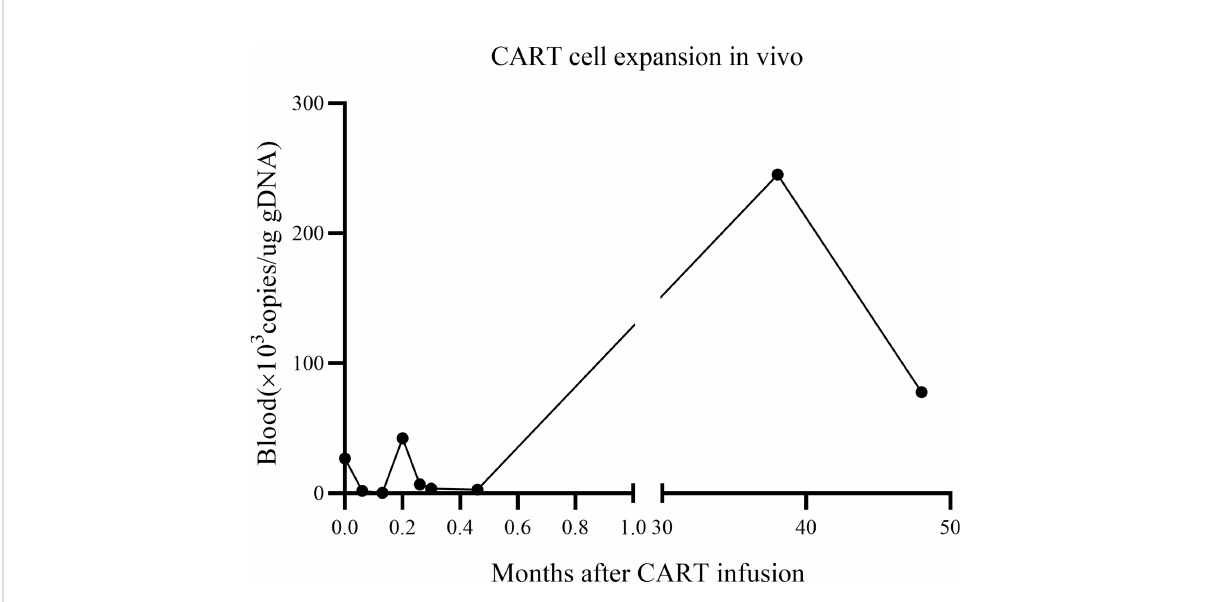
FIGURE 3 CART cell expansion in vivo . CART, chimeric antigen receptor